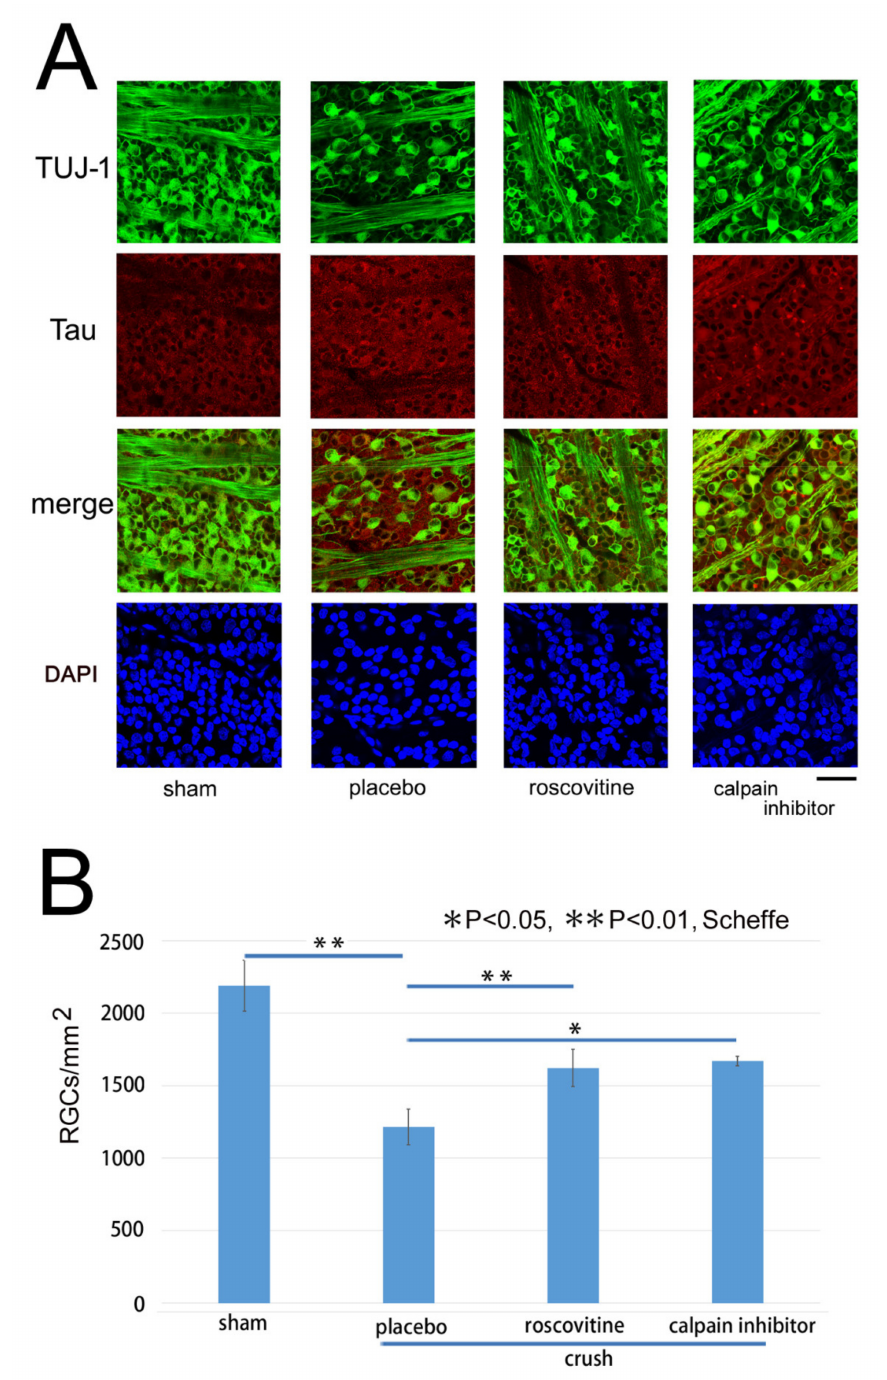
Figure 6. Representative confocal images of flat-mounted retinas double-stained with Tuj-1 and tau antibodies demonstrating the protective effects of roscovitine and calpain inhibitor on retinal damages. ( A ): The number of RGCs stained with Tuj-1 (green) is clearly reduced after the ONC (placebo), while roscovitine and calpain inhibitor preserve the number of RGCs. The expression of tau (red) appears to be intensified in the RGCs where immunoreactivities to Tuj-1 are poor after ONC (placebo). Roscovitine and calpain inhibitor seemed to reduce the degree of increase in tau expression after ONC. (Bar = 100 µ m). ( B ): Number of Tuj-1 positive cells most likely the RGCs on day 7 after the ONC. RGCs are significantly fewer than that of the sham control on day 7 (placebo), and roscovitine and calpain inhibitor significantly reduce the degree of decrease. (* p < 0.05, ** p < 0.01, Scheffe; n = 3–6 in each